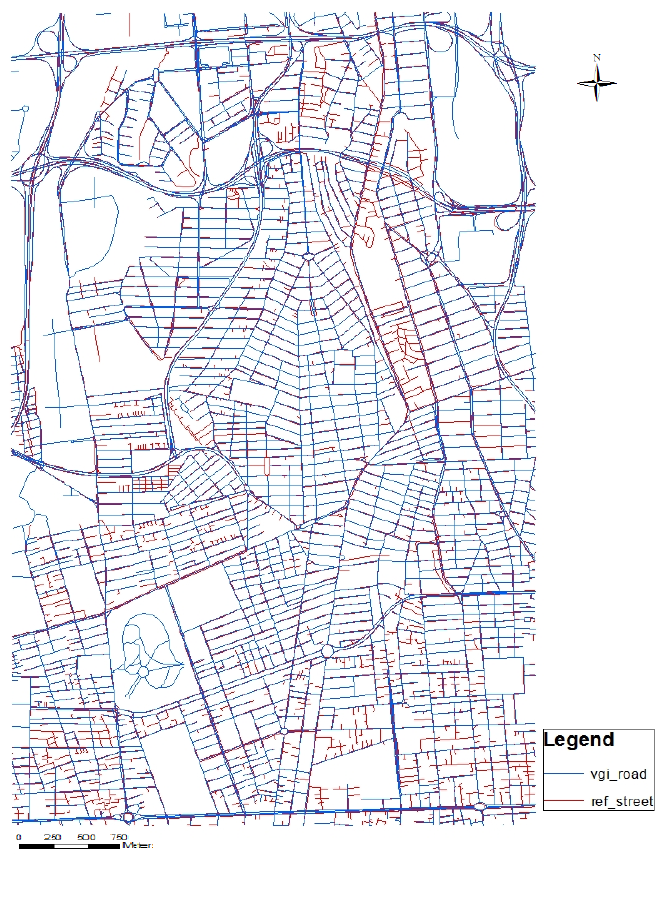
Figure 3. Overlaying the OpenStreetMap (OSM) map with the reference